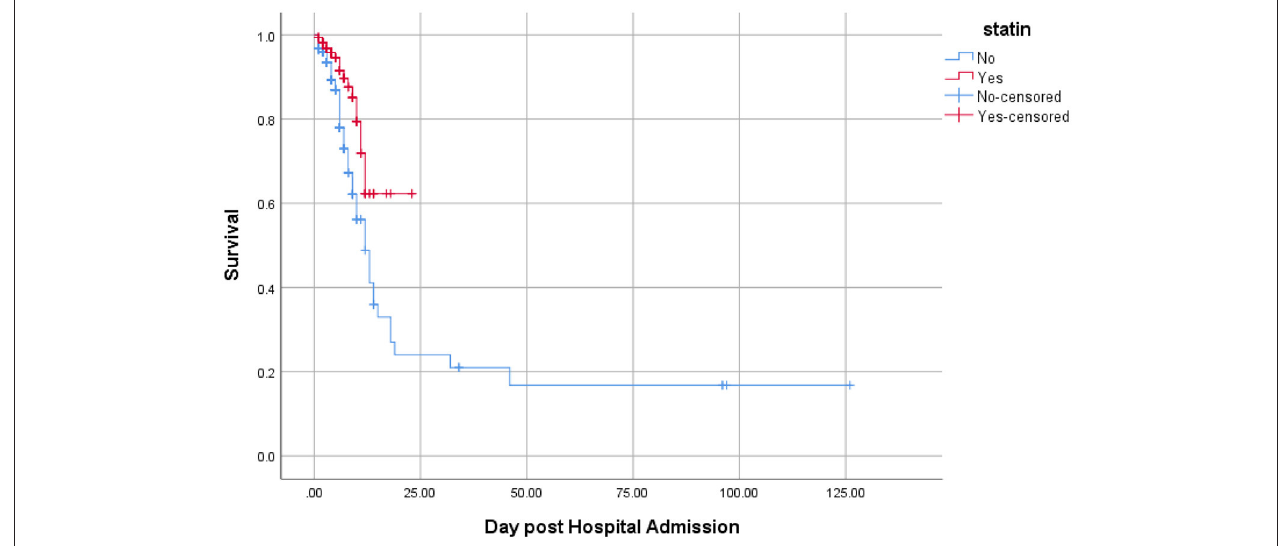
FIGURE 2 | Kaplan-Meier curve comparing the survival time (in days) between statin users and statin nonusers considering the composite of mortality, ICU admission, and intubation as the event. Value test log-rank = 11.06; p -value =